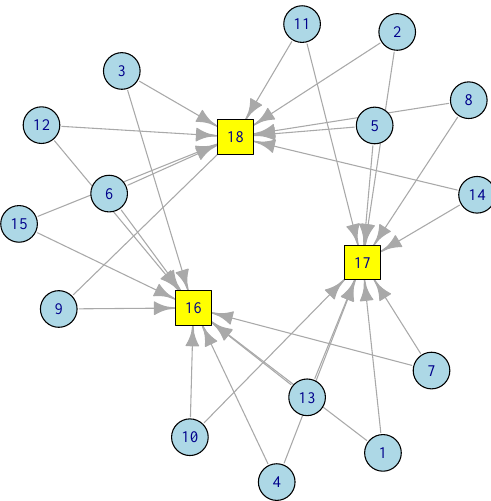
Figure 2. A configuration of edge sensor network with 3